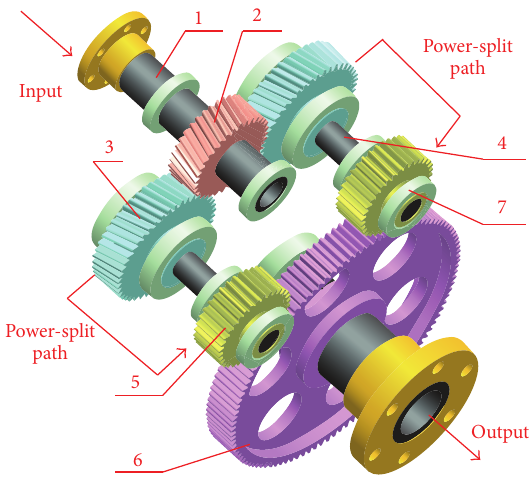
Figure 1: Example of a power-split transmission design with dual power paths. 1: input shaft, 2: I-stage helical pinion, 3: I-stage helical gear, 4: torsion shaft, 5: II-stage spur pinion, 6: II-stage spur gear, and 7: II-stage spur pinion.